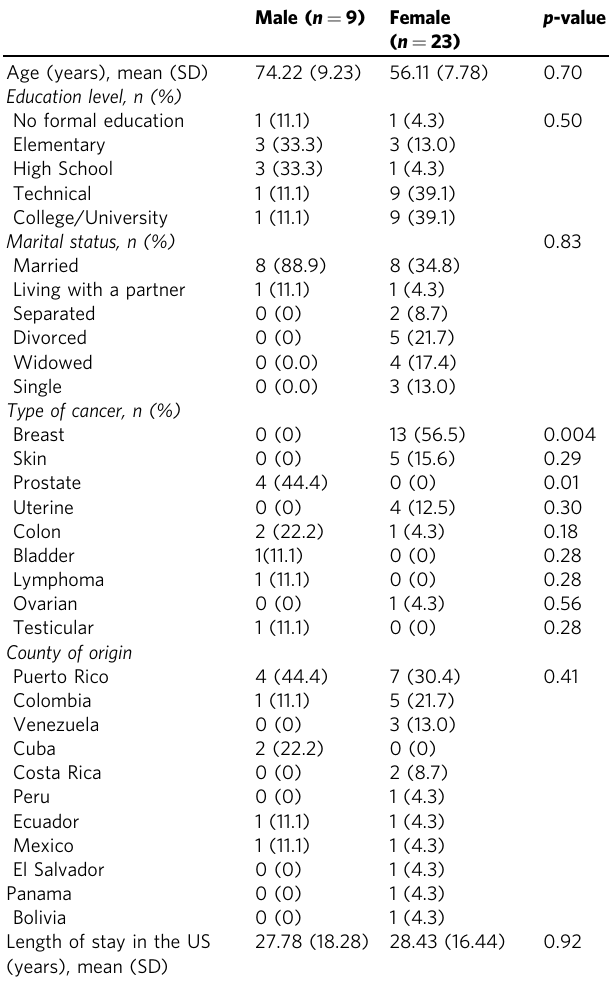
Table 1 Characteristics of the study population. Table 2 Characteristics of the study population by